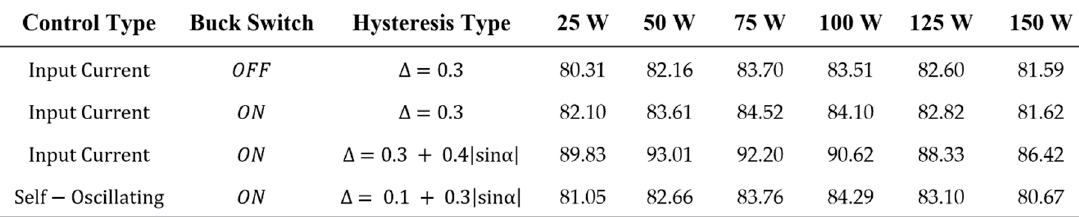
Figure 28. Microinverter results at different output powers, ( a ) efficiency, and ( b ) switching frequency.